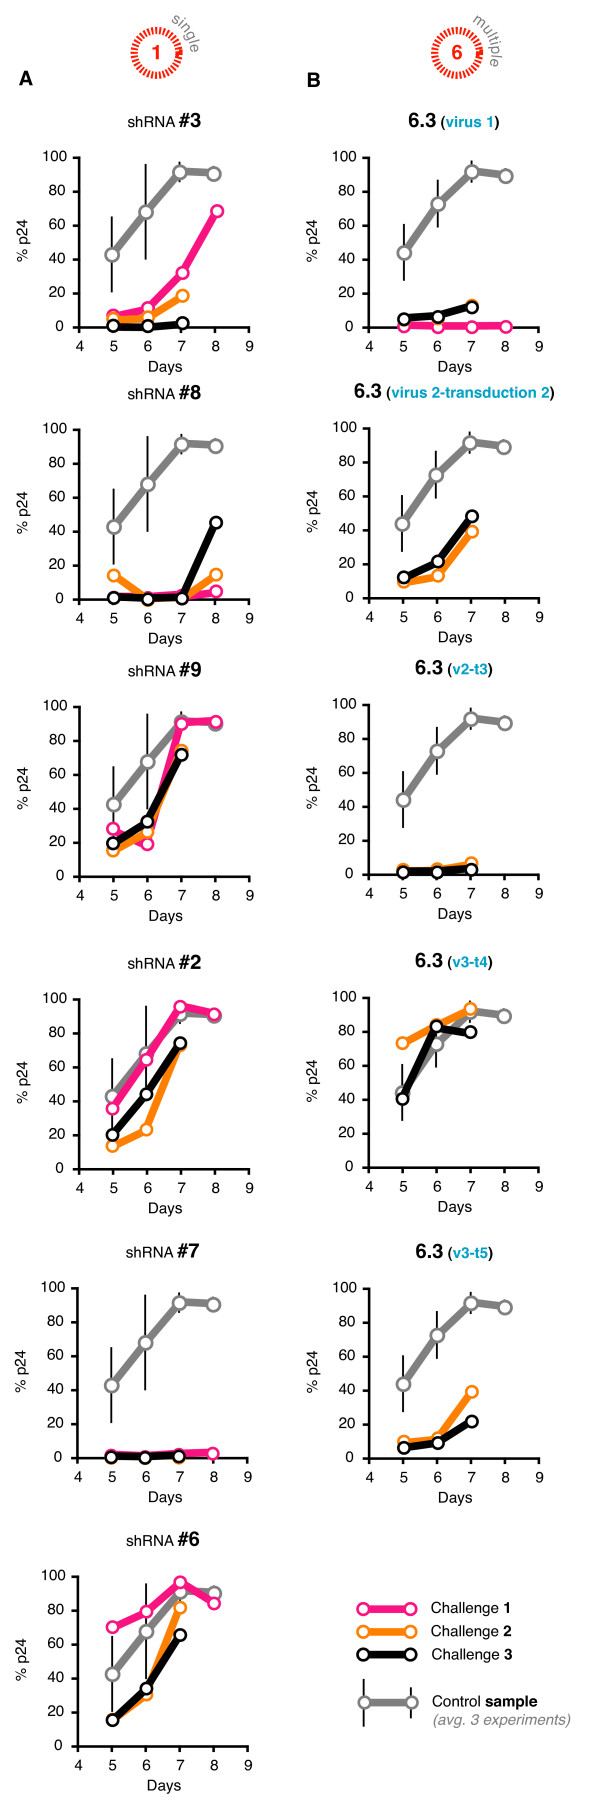
Inconsistent challenge results from repeated stable transductions of 6.3. (A) We challenged G418 selected CEMT4 polyclonal populations of each of our 6 single shRNA vectors with HIV-1. Suppressive activities were inferred by intracellular p24 levels measured between 5 and 8 days later. Each population was assayed in 3 independently repeated experiments. A control vector expressing a single shRNA unmatched to HIV-1 was also tested 3 times (grey points), with the average values of 3 experiments and 95% confidence intervals (CI) shown. (B) Five separate 6.3 polyclonal populations were generated through independent transductions (t1 to t5) using 3 different lentiviral batches (v1, 2, and 3). Each population was similarly selected and challenged in 3 independently repeated experiments with HIV-1. The control vector was a combination of 6 shRNAs unmatched to HIV-1 that were assembled in the same format as 6.3 (grey points), with the average values of 3 experiments and 95% confidence intervals (CI) shown.